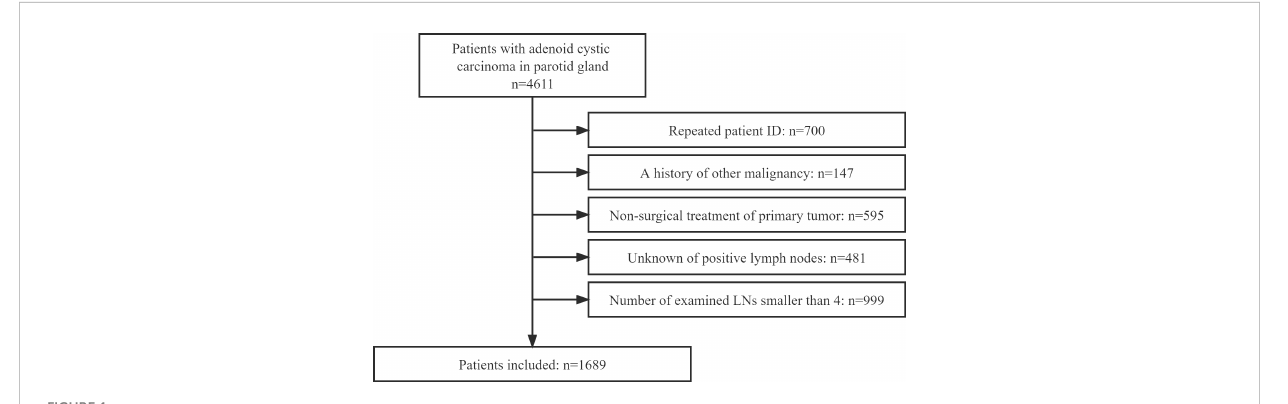
FIGURE 1 Flowchart of the enrolled